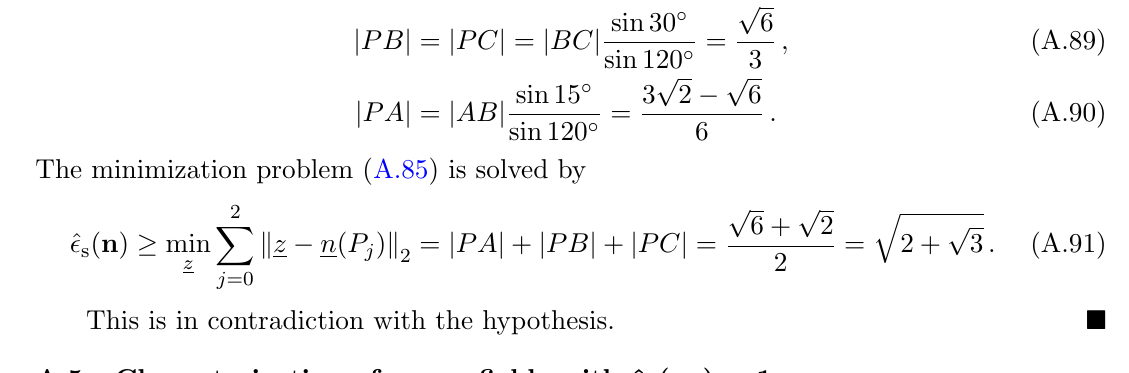
Figure 7 . The minimization problem in eq. (A.85) is equivalent to (cid:12)nding the Fermat point P of the triangle ABC , which is right-angled in A , and has side lengths j AB j = j AC j = 1 and j BC j = The Fermat point is characterized by the property that the three angles in P are all equal to 120 (cid:14) . Elementary trigonometry